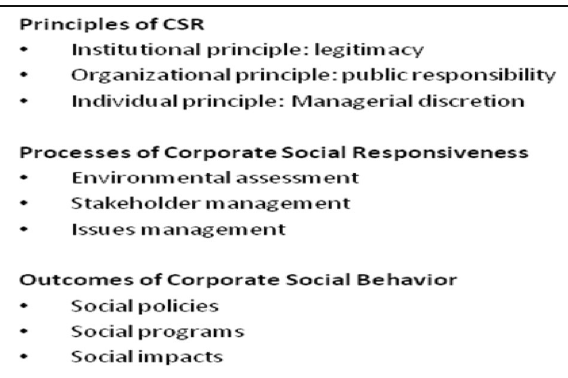
Table 1 Wood ’ s Model of CSP. Source: Wood (1991, p.